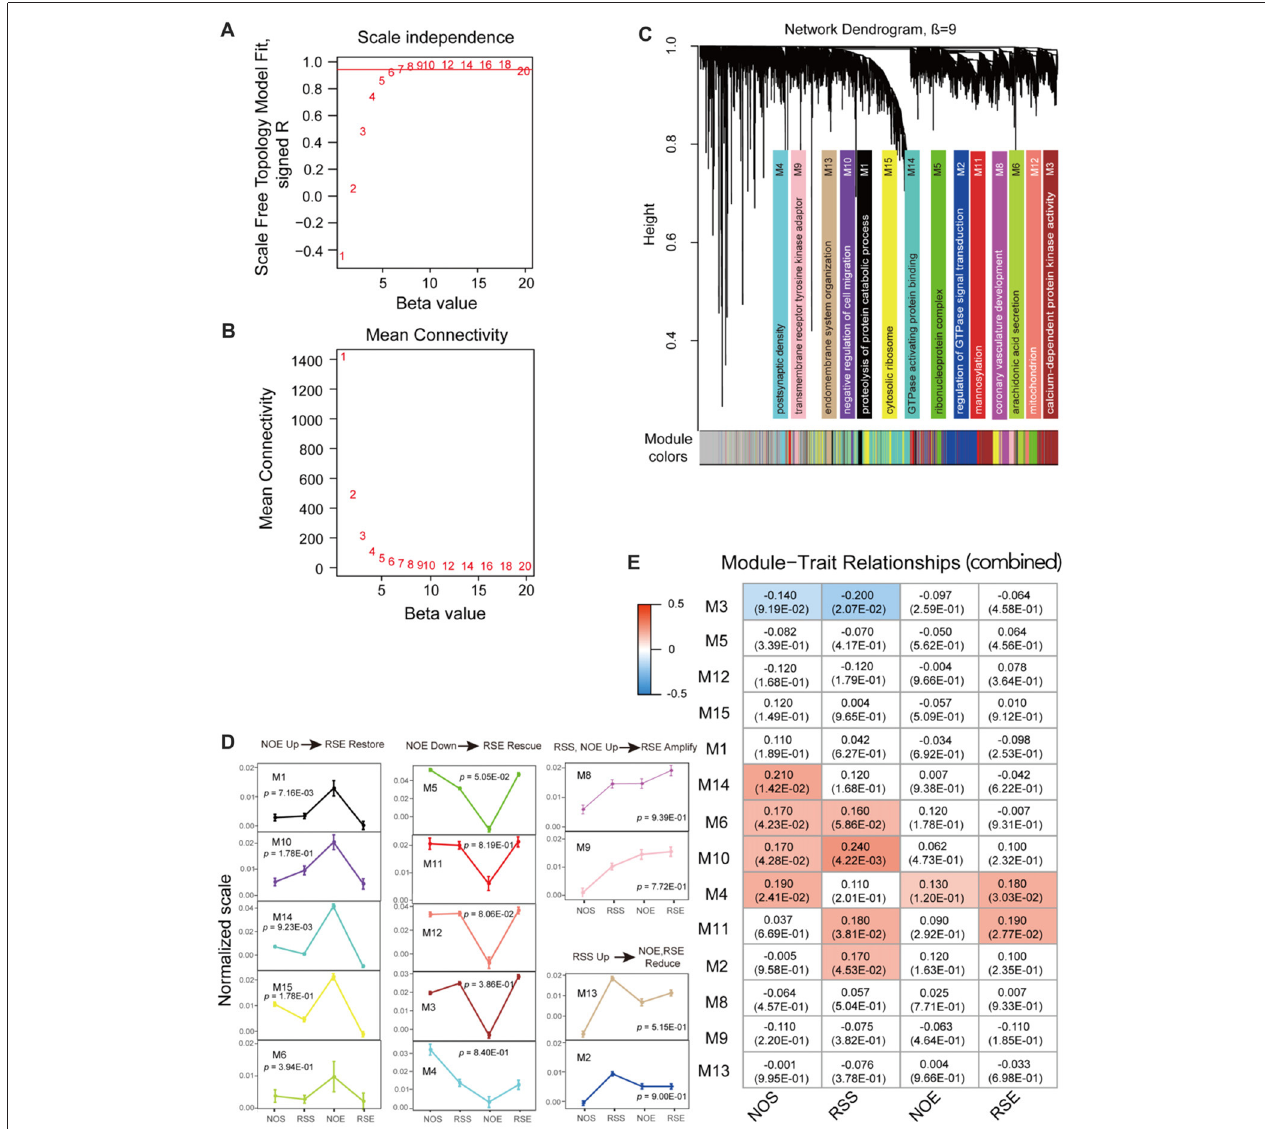
FIGURE 2 | Co-expression module analyses. (A) The soft thresholding index R 2 (y-axis) as a function of different powers β (x-axis). (B) The mean connectivity (y-axis) is a strictly decreasing function of the power β (x-axis). (C) Fourteen co-expression modules identified from the combined dataset. WGCNA cluster dendrogram groups genes ( n = 6413) measured across BXD Hippocampus into distinct gene modules (M1–14) defined by dendrogram branch cutting. These modules were significantly enriched for gene ontologies linked to discrete cellular functions and/or organelles in the brain. Genes that did not belong to any modules were housed in the gray modules. The gray gene modules were ignored in this study. (D) Four expression patterns. Four expression patterns were found: up-regulation in No restraint stress and given an ethanol injection (NOE) but restoration in Restraint stress followed by an ethanol injection (RSE) (NOE Up → RSE Restore); down-regulation in NOE but rescue in Restraint stress followed by an ethanol injection (NOE Down → RSE Rescue); up-regulation in both Restraint stress followed by a saline injection (RSS) and NOE, and further amplification in RSE (RSS, NOE Up → RSE Amplify); up-regulation in RSS but reduction in NOE and RSE (RSS